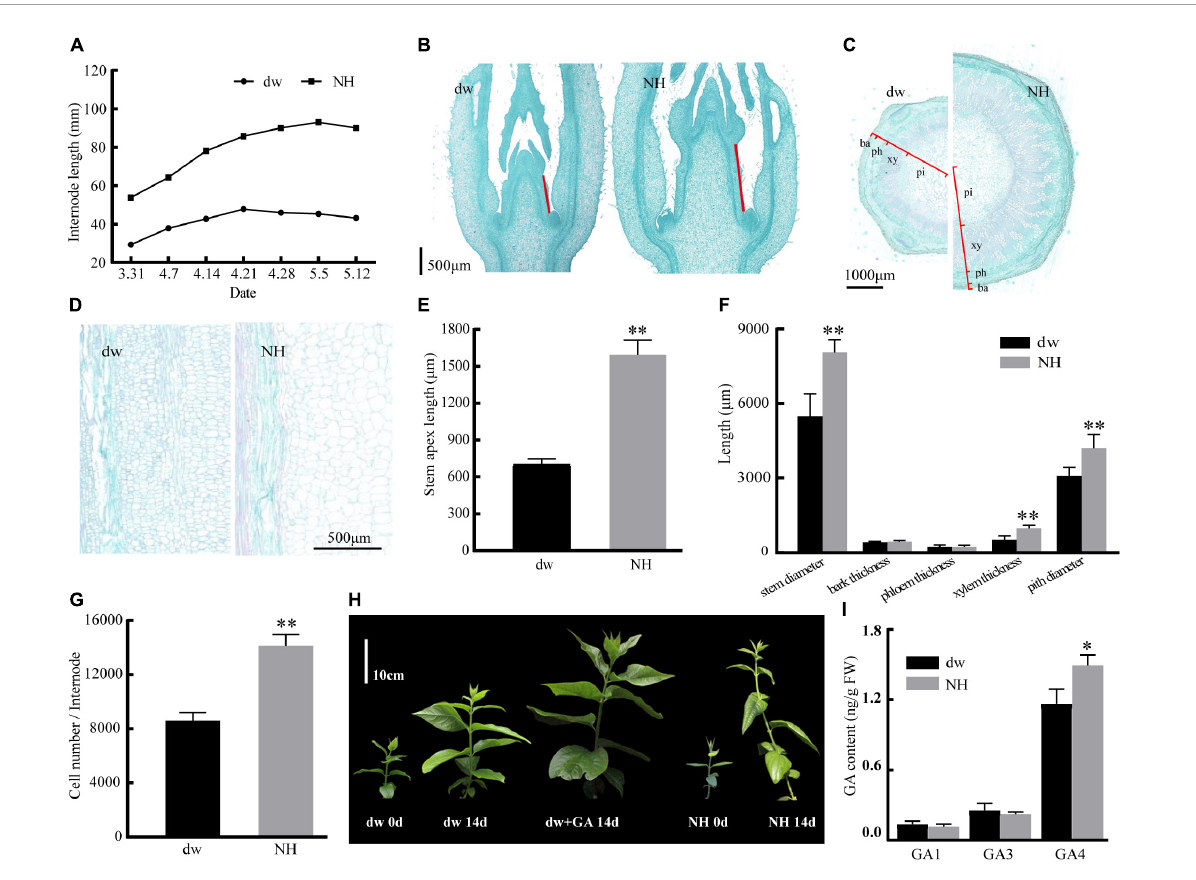
FIGURE1 Response of internode length, slicing of dw and NH, dw to exogenous GA treatment. (A) Internode length in different periods. Panels (B,E) are the paraffin sections of the stem tip, with red lines indicating the length of the stem tip. Panels (C,F) are transverse sections of the stem. ba, bark; ph, phloem; xy, xylem; pi, pith. Panels (D,G) are the longitudinal sections of the stem. (H) The effect of hormone treatment on the growth of dw and NH. (I) Endogenous GA content. The * and ** indicate a significant difference from NH at p < 0.05 and p < 0.01, respectively, as determined by the Student t